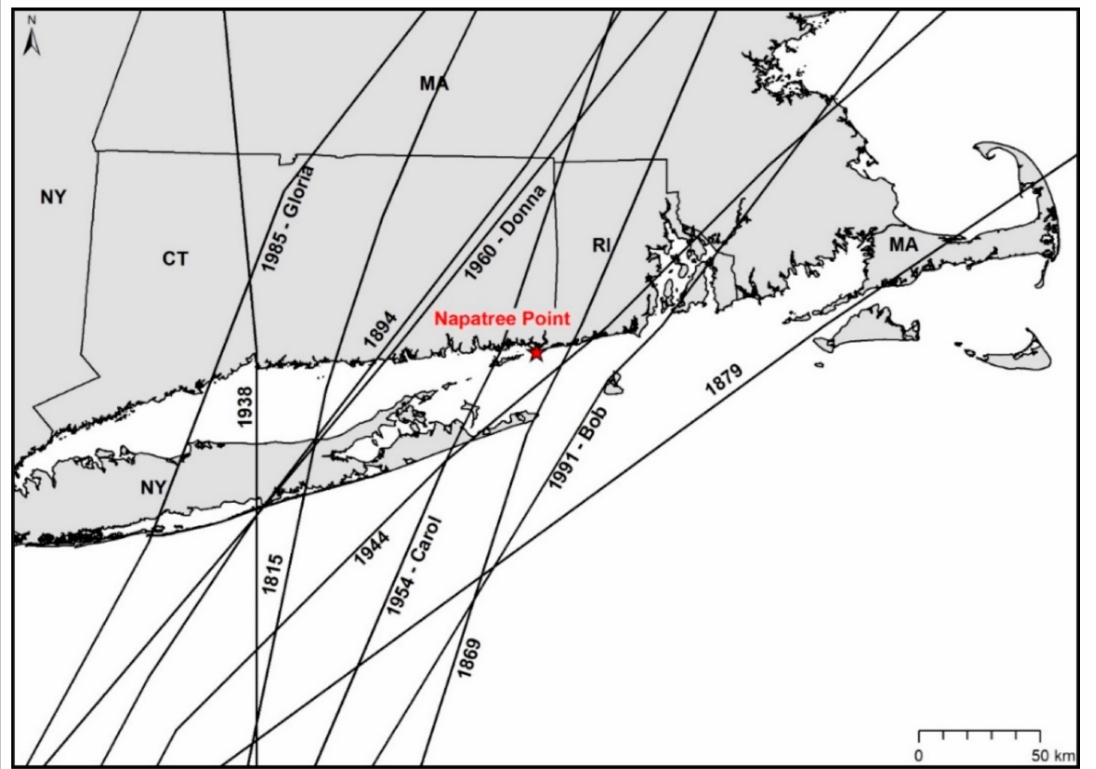
Figure 3. Storm tracks of hurricanes that made landfall within 200 km of Napatree Point (Storm tracks from NOAA Digital